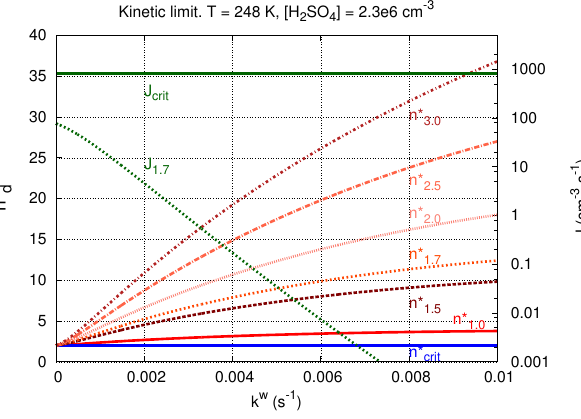
Fig. 3. Influence of a sink on the interpretation of measurements of particle formation rates in the case of kinetically limited nucleation. In such a system strong deviations between the “true” n ∗ (blue line) and the “apparent” n ∗ (red lines) exist for the entire range of at- d mospherically relevant H 2 SO 4 concentrations and nucleation rates. The labels and axis are the same as in Fig. 1.